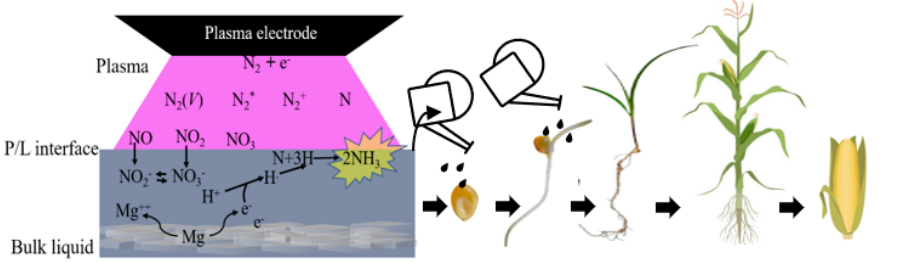
Figure 1. Schematic representation of the experiment